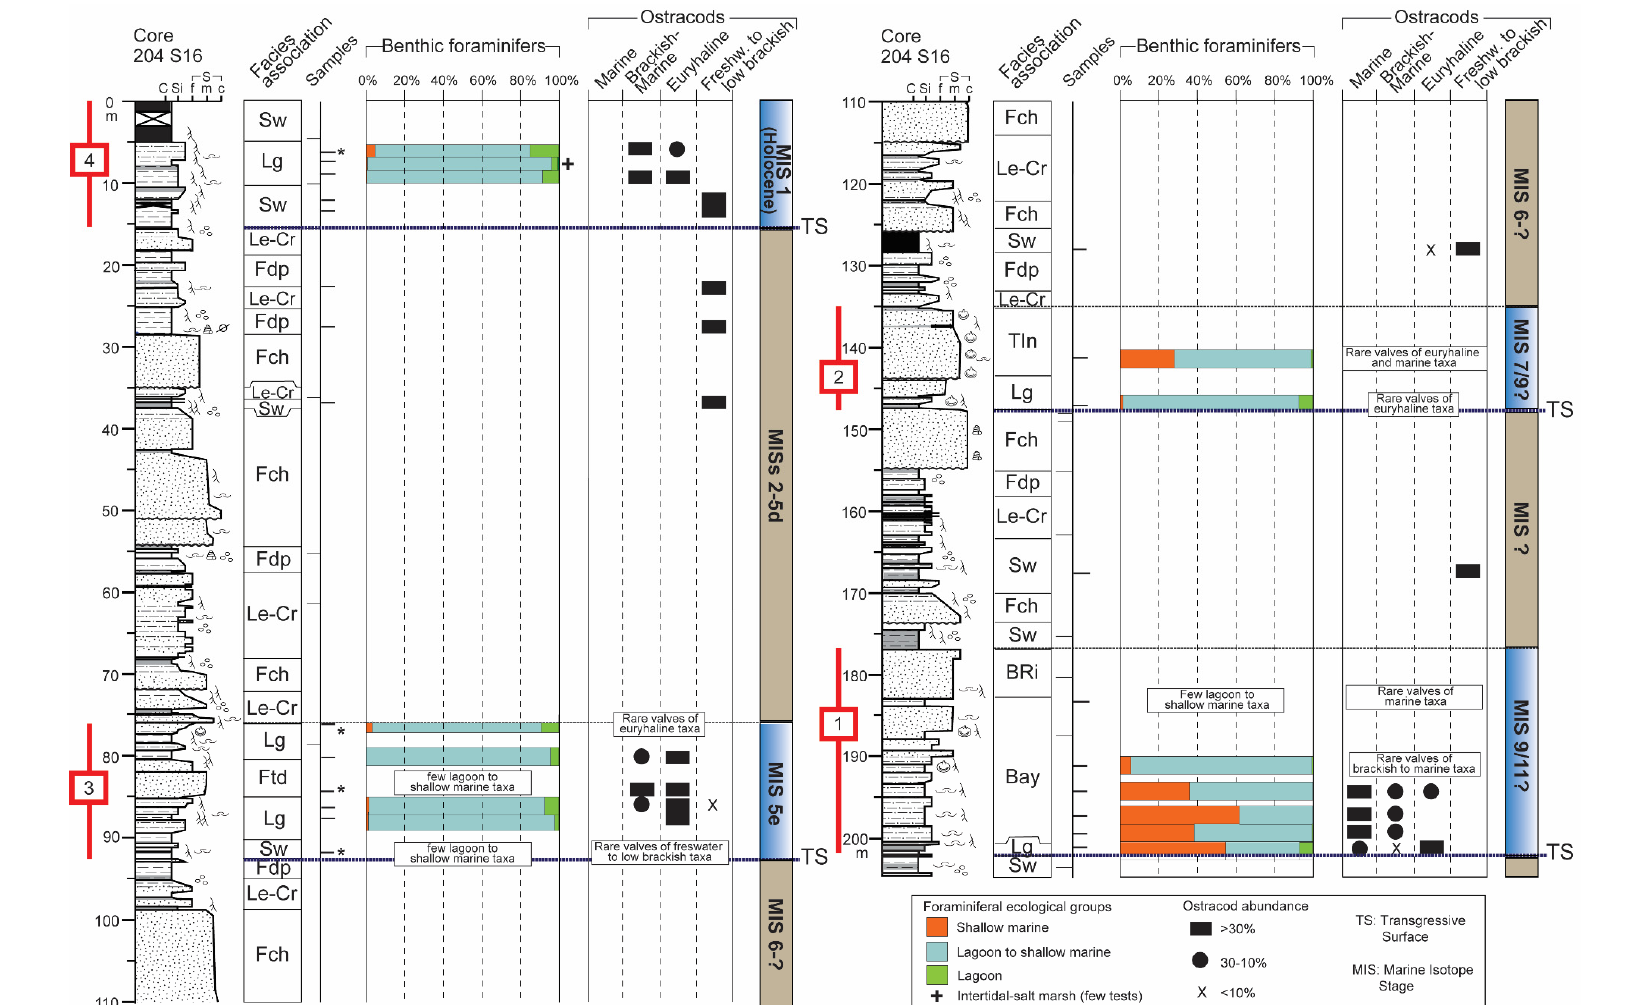
Figure 4. Stratigraphic distribution of benthic foraminifer and ostracod ecological groups along core 204 S16. Boundaries of the Units 1–4 are highlighted. TS: Transgressive Surface. The interpretation in terms of Marine Isotope Stages (MISs) is also reported. See the legend and caption of Figure 3 for lithological information.